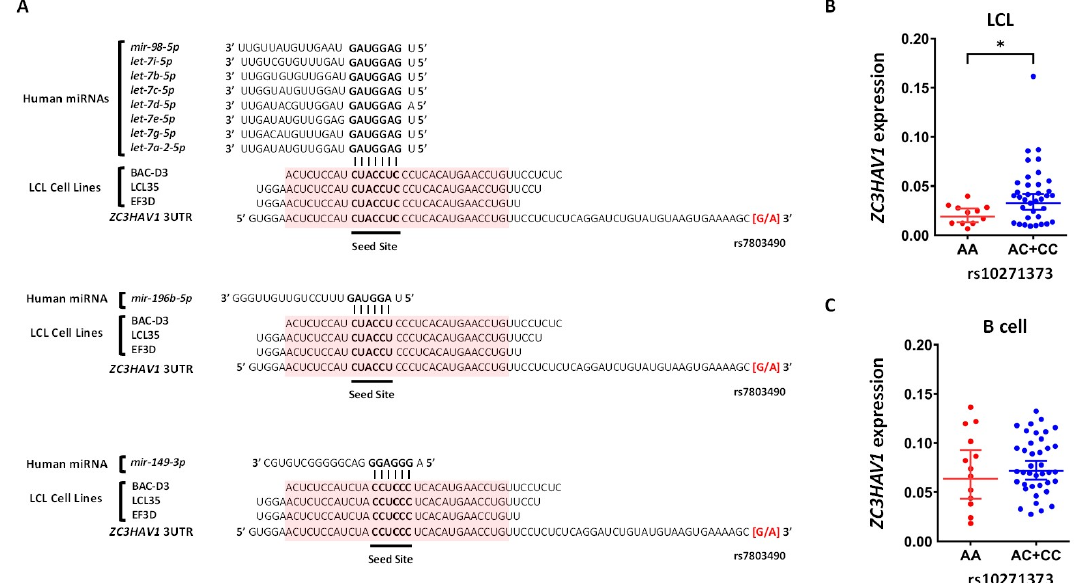
Figure 6. Putative cellular miRNAs target sites on ZC3HAV1 and the genotype effect of MS risk SNP on ZC3HAV1 expression in LCLs and B cells. ( A ) The putative cellular miRNAs target sites on ZC3HAV1 which were located nearby the SNP rs7803490 in LD with MS risk SNP rs10271373. The consensus sequences obtained using pipeline B are highlighted red. The rs10271373 genotype effect on expression of ZC3HAV1 in LCLs ( B ) and B cells ( C ). AA is the risk genotype of rs10271373, and CC is the protective genotype. * indicates p ≤